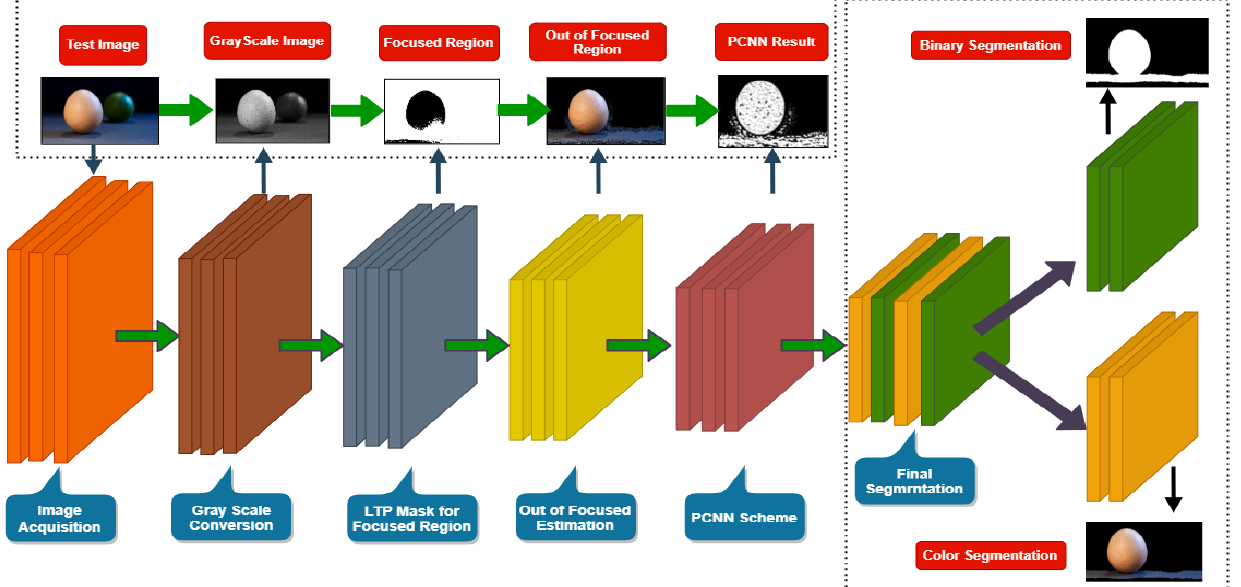
Figure 6. The Block diagram of the proposed scheme is illustrated. The primary points are displayed on the left side, whereas the right side of the figure represented the production and role of each image in the proposed